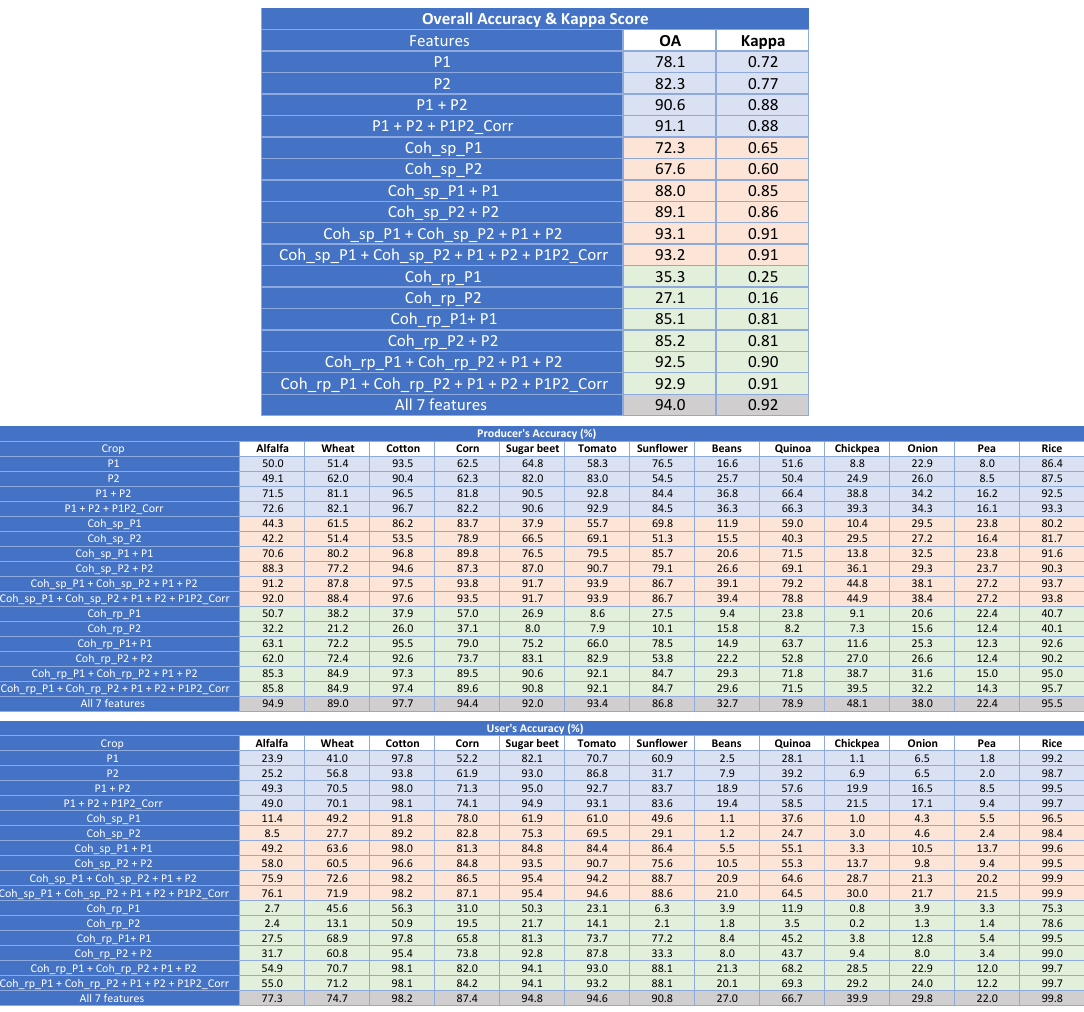
Table 6. Classification scores at pixel level with Pauli channels. Shading colour: blue for polarimetric features, pink for single-pass interferometric coherence features, green for repeat-pass interferometric coherence features, and grey for all